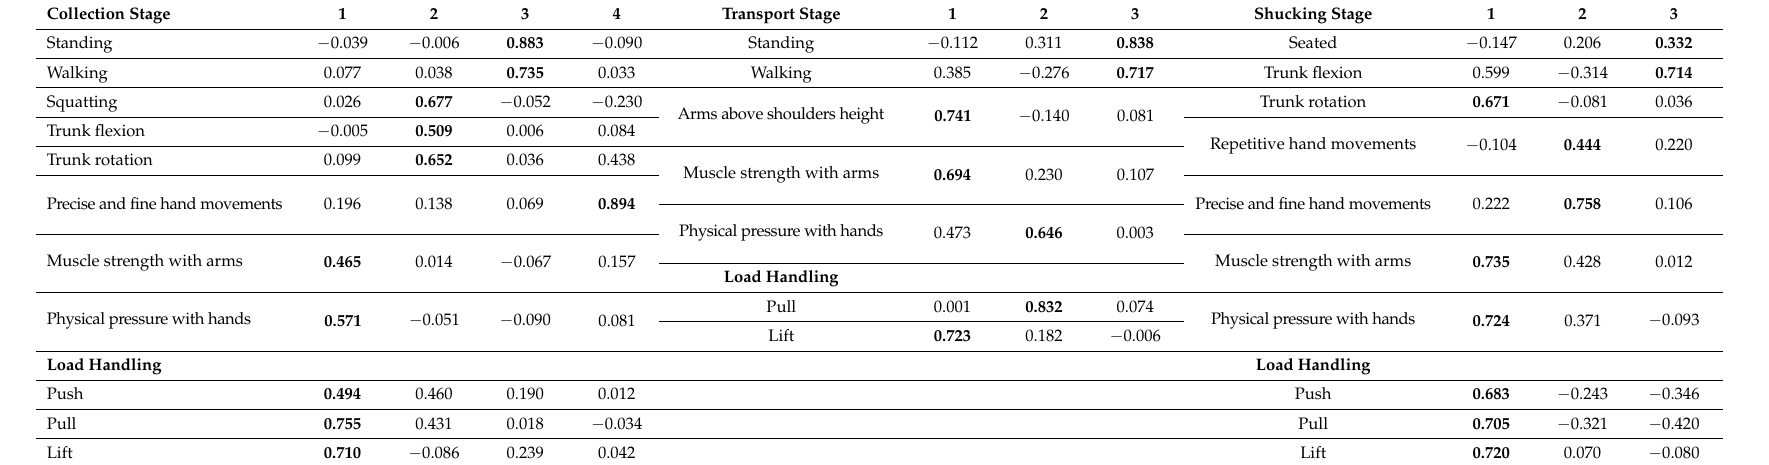
Table 3. Results of factor analysis for the variables related to posture, muscular force and handling of the